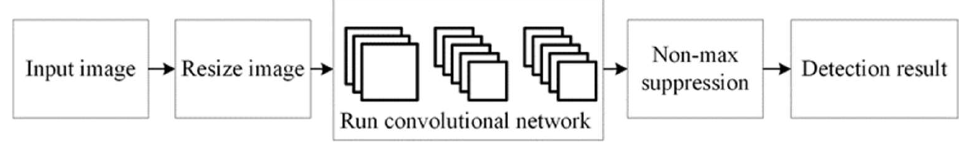
Figure 1. The structure of the YOLO detection algorithm. The YOLO algorithm divides the input image into an S × S grid. Each grid cell predicts B bounding boxes and confidence scores. The mathematical relation between Con f idence ( C ), Pr ( obj ) ( P(o) ), and IOU ( I ) is shown in Equation (1).